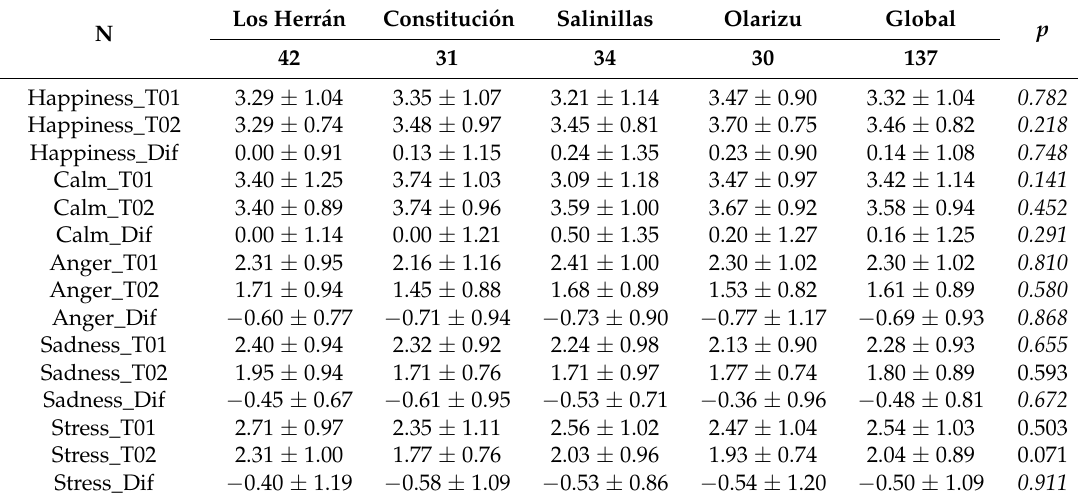
Table 4. Characterisation of emotional states at the beginning (T01) and end (T02) of the urban experience, and the difference between both (mean scores ± standard deviation) in the four urban places, and significance ( p ) of ANOVA analysis.